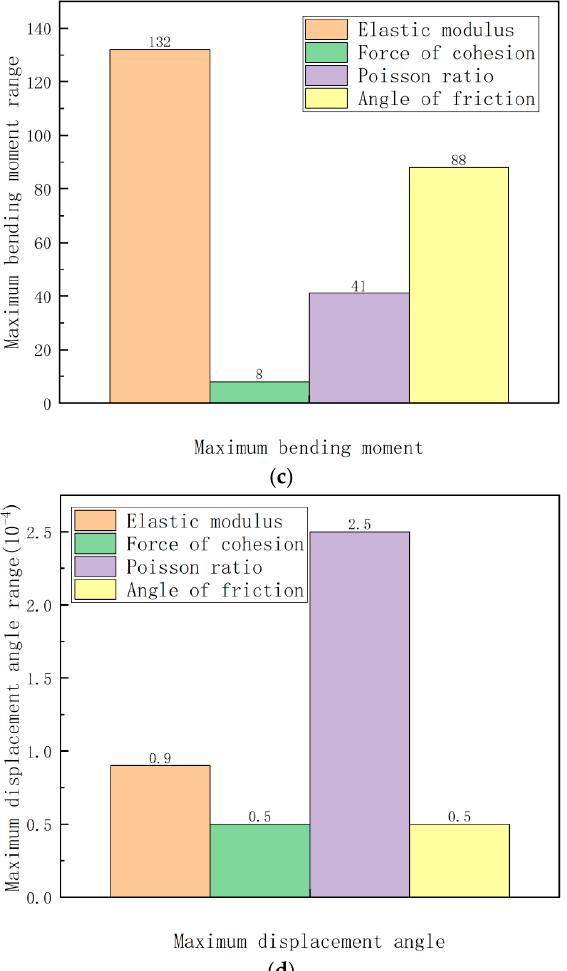
Figure 9. Range of the structural dynamic response index corresponding to the variation in soil parameters. ( a ) Maximum axial force range of the feature points. ( b ) Maximum shear range of the feature points. ( c ) Maximum bending moment range of the characteristic points. ( d ) Maximum displacement angle range of the characteristic points on the roof and fl oor.